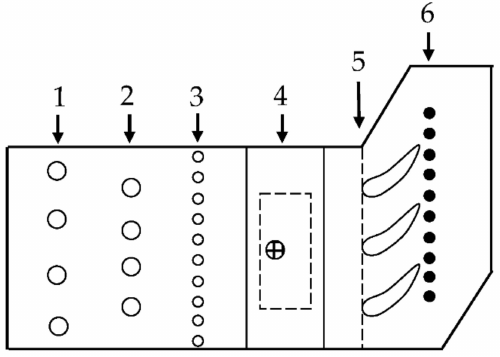
Figure 2. C3X test facility schematic.